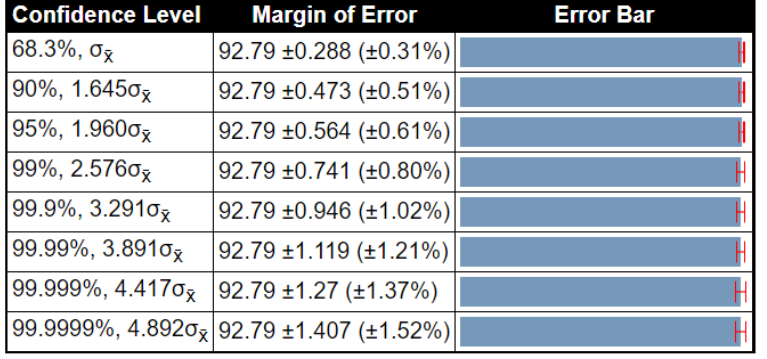
Figure 10. Confidence interval of statistical test for different critical value of t -test (BraTS 2018 dataset).